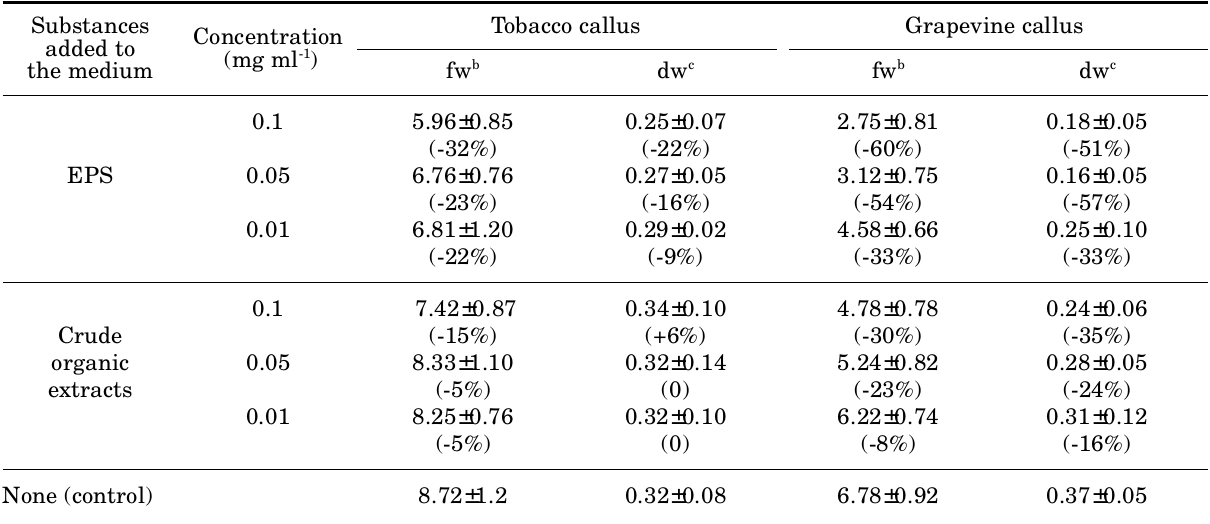
None (control) a Values are the means of 3 replicates ± S.D. In parentheses, percentage of growth reduction compared with controls. b Fresh weight (g/plate). c Dry weight